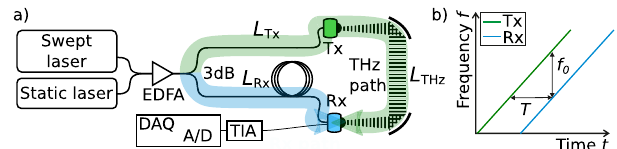
Fig. 1 Schematic setup and principle of operation of the optoelectronic FMCW spectrometer. a Schematic drawing of the optoelectronic swept delayed self-heterodyning FMCW THz setup. Note that the system is fully fi ber-coupled without any free-space optics. EDFA erbium-doped fi ber ampli fi er, 3 dB 3 dB coupler, L Tx , L R x optical fi ber path length in the Tx and Rx arm, respectively, including an optional static fi ber delay; L THz THz path length, Tx fi ber-coupled THz emitter, Rx fi ber-coupled THz receiver, TIA transimpedance ampli fi er, DAQ data digitization and acquisition system. The colored arrows highlight the Tx path and Rx path, and indicate the path lengths relevant for the total delay time that arises from the path length asymmetry. b When the frequency f of the swept laser is tuned at constant velocity ν S , a frequency offset f 0 = T d f /d t occurs for a delay time T